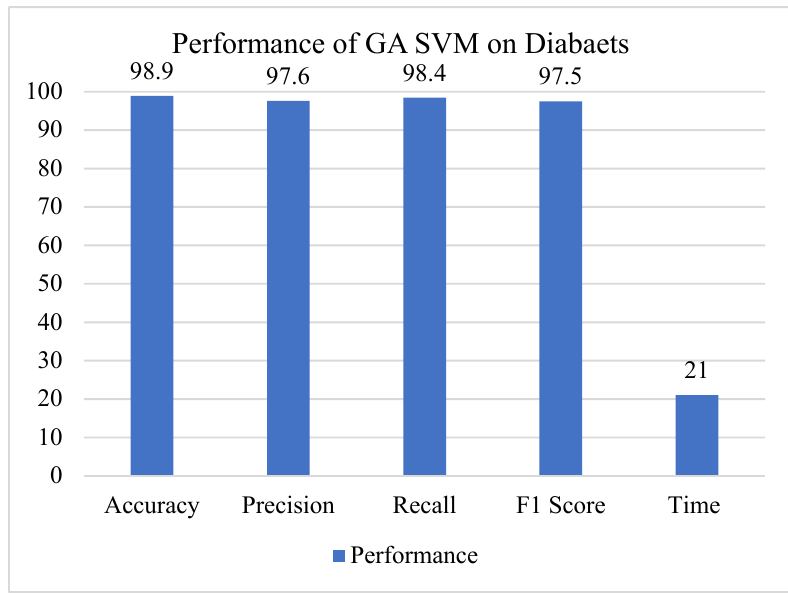
Figure 13. Performance of GA ‐ SVM on Diabetes.